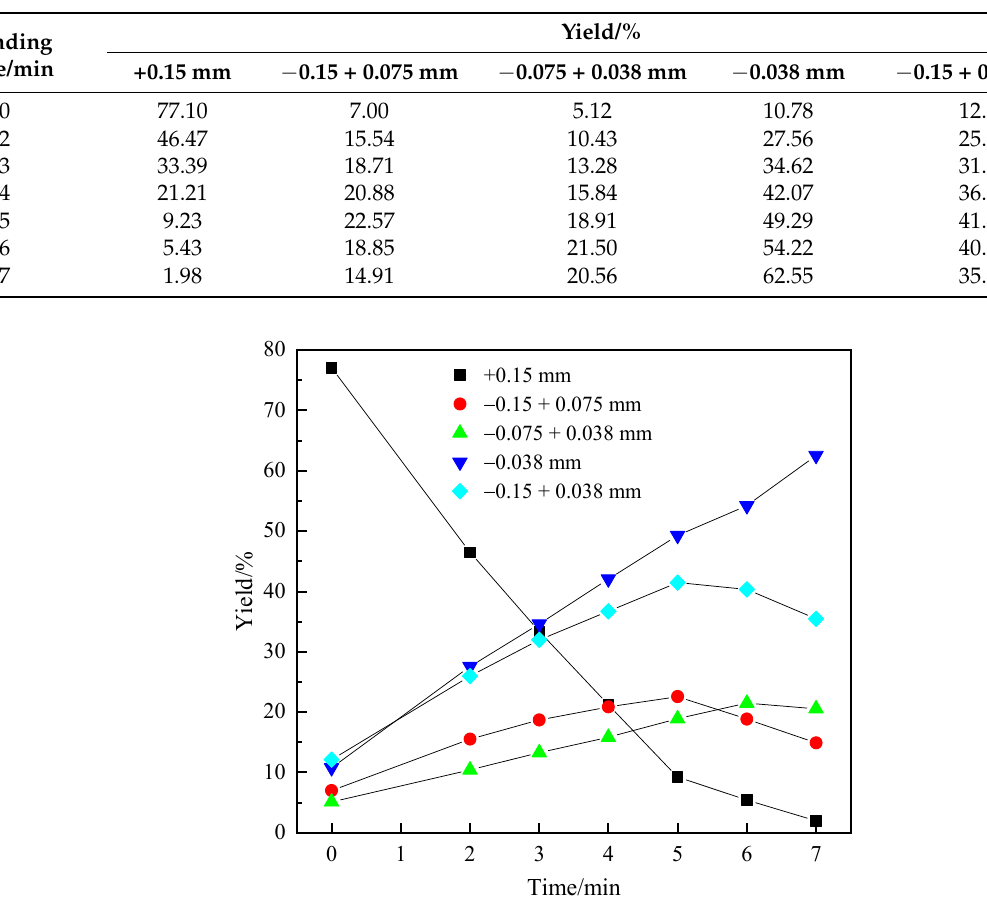
Figure 1. Particle size of grinding product at different grinding times.